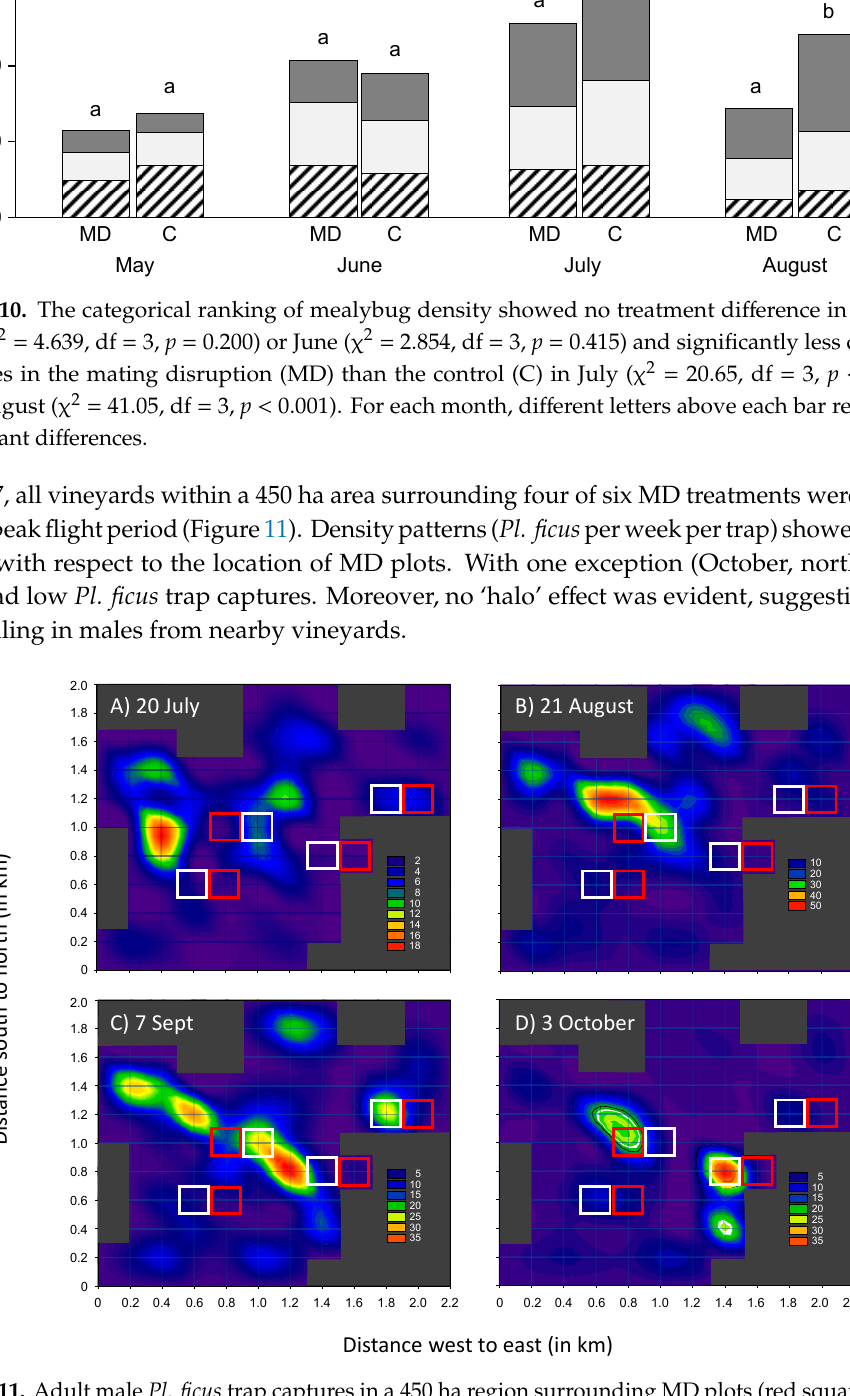
Figure 11. Adult male Pl. ficus trap captures in a 450 ha region surrounding MD plots (red squares) and the corresponding control plots (white squares) that received CheckMate dispensers hung at 61.5 g/ha in 2007. For each graph, key in lower right is Pl. ficus density per week for the different monthly sampling periods ( A – D ). Dark gray areas indicate non-grape crops or buildings. Maps were constructed using the Contour Graph function in SigmaPlot for Windows Version 12.5, Systat Software, Inc.